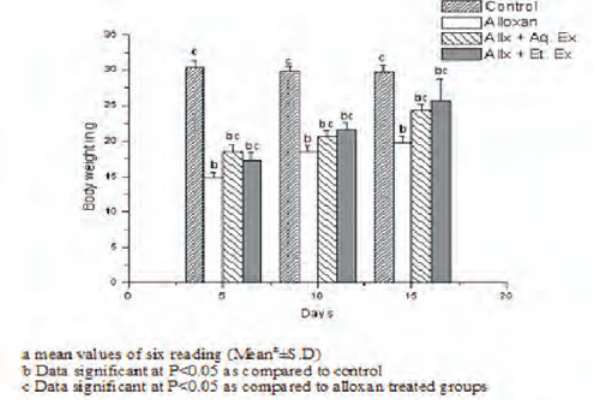
Figure-2. Effect of Aq.Ex and Et.Ex of A graveolens L. on organ weight expressed as mean